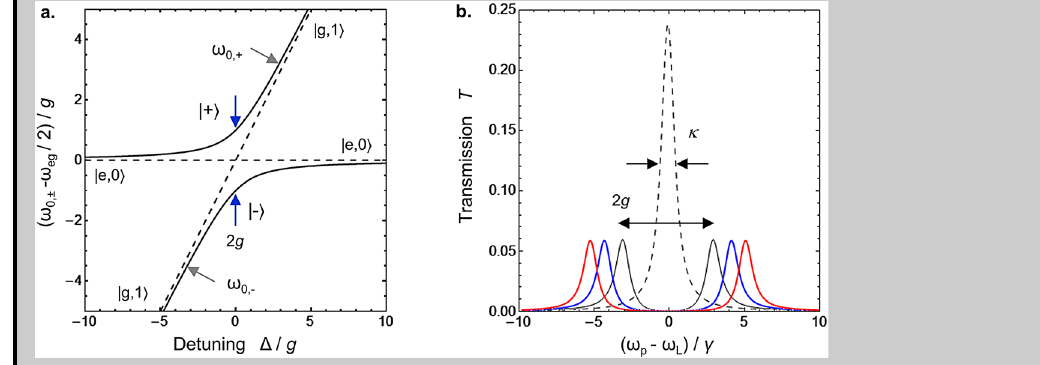
̅̅ √ ̅̅ √ ⃒⃒⃒ ⃒⃒⃒ 2 . The eigenstates at selected locations have been marked. 2 and | − 〉 = (| e , 0 〉 − g , 1 〉 ) / g , 1 〉 ) /